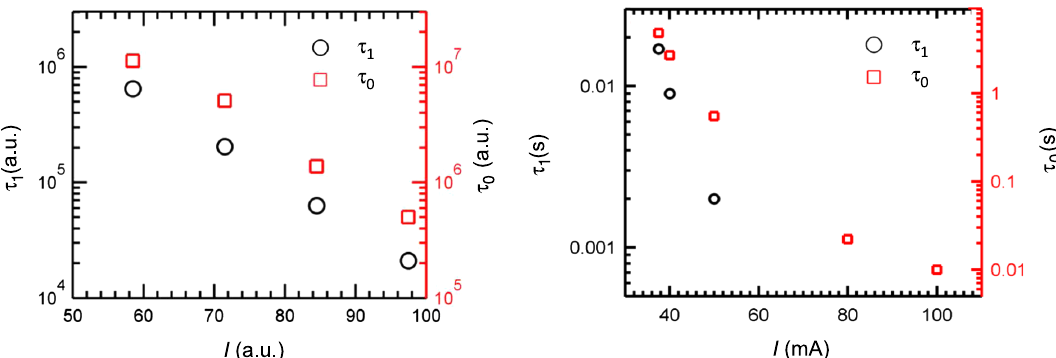
FIG. 10. Evolution of the characteristic times for different applied currents for both simulations (left panel) and experiments (right panel). It can be seen that both times follow an approximate exponential dependence with I and that there exists a relative proportionality between them as predicted by our